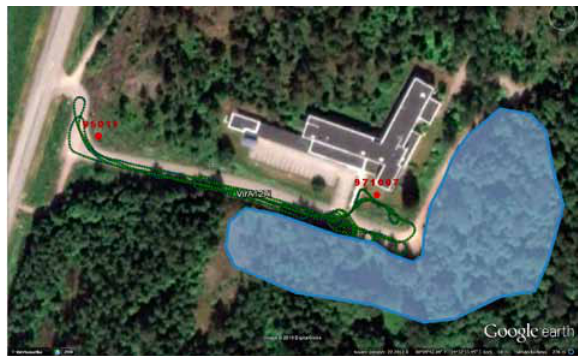
Fig. 2. Aerial photograph of the test field presenting the location of the benchmarks, harvested trees (blue polygon) and the trajectory from the MLS measurements (green dotted curve) (image: Google Earth)